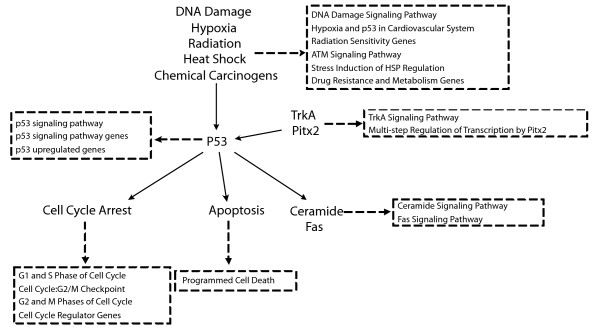
Relationship between the significant gene sets and p53. Relationship between significant gene sets and p53. Solid arrows describe the interactions between p53 and different biological processes or genes. Dashed arrows show the definition of those gene sets in the corresponding dashed rectangle. The solid arrows are constructed based on previous works in [35-40].